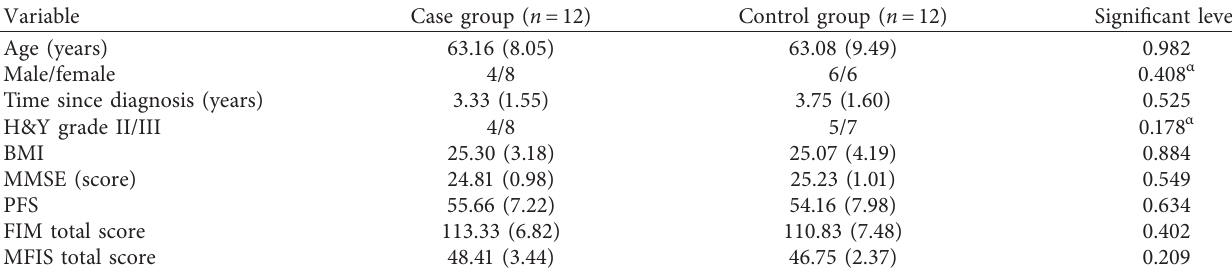
Table 1: Demographic data, mean score, and standard deviation of the patients ( n � 24).